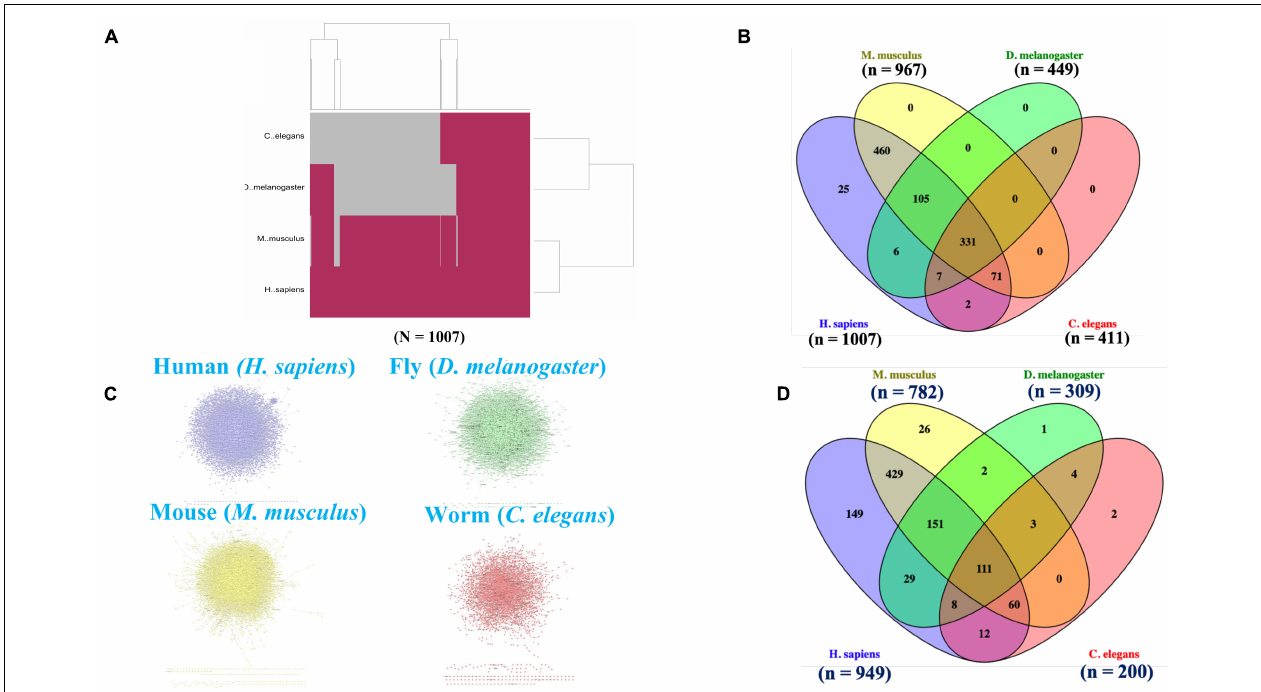
FIGURE 1 | Cross-species orthologs and protein-protein interaction network (PPIN) mapping. (A) A hierarchical clustering highlighted the orthologous for the 1007 human aging and longevity related genes in three model organisms (e.g., mice, flies, and worms) by “Gene to Gene” (1:1) orthologs mapping using Ensembl Gene ID. (B) Venn diagram shows an overlapping of 331 orthologs genes within the four species. The (n) indicates the number of orthologous genes present in each respective species. (C) The protein interactomes for human, mice, flies and worms are curated using Integrated Interactions Database (IID) based on experimentally detected Protein-Protein Interactions (PPIs) from 9 curated databases (BioGRID, IntAct, I2D, MINT, InnateDB, DIP, HPRD, BIND, and BCI). (D) Venn diagram shows an overlapping of 111 orthologs genes within the PPIN of four species. The (n) indicates the number of orthologous genes present in respective PPIN of each species.